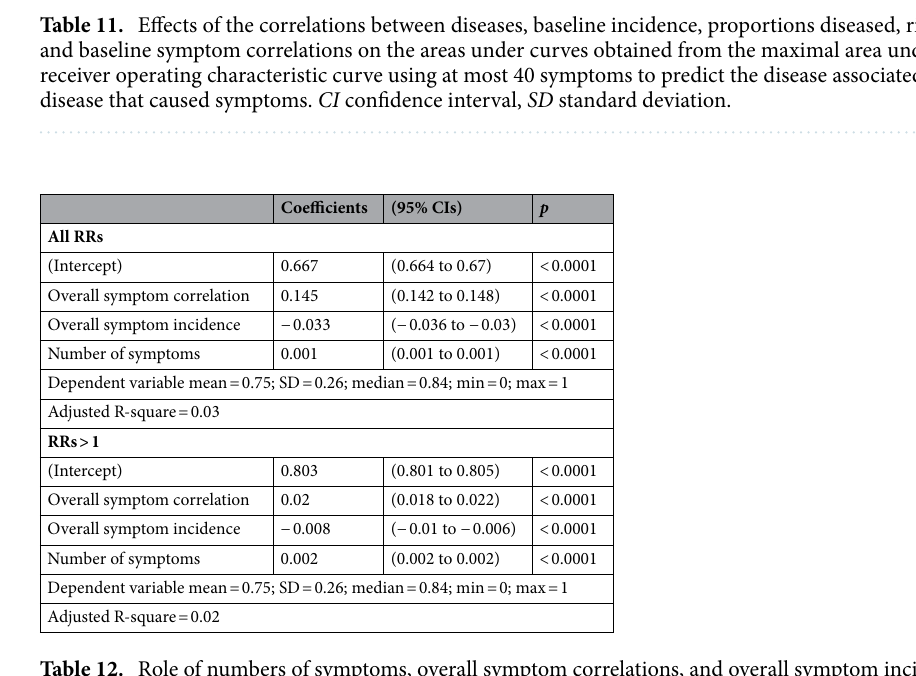
Table 12. Role of numbers of symptoms, overall symptom correlations, and overall symptom incidence on the AUCs for disease diagnosis. CI confidence